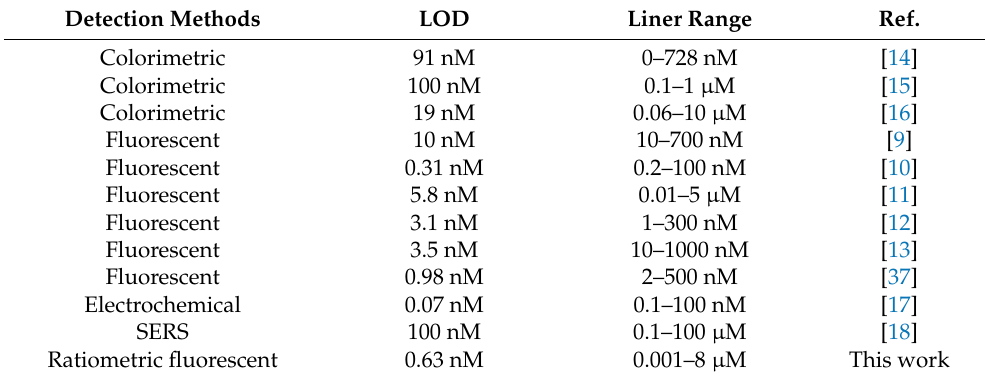
Table 1. Comparison of different methods for the detection of